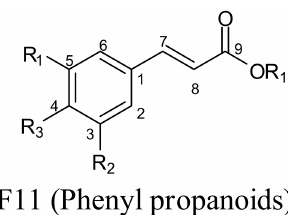
Figure 2. Phenyl propanoids. R 1 , R 2 , R 3 , R 4 = H, OH, OCH 3 , O -sugar, prenyl, isoprenyl, phenethyl, benzyl,